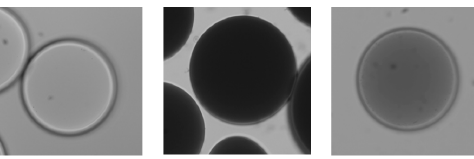
Figure 4. Toluidine blue (TBO) stained PEG SCPs before functionalization with crotonic acid (CA) ( left ). After CA functionalization PEG-CA SCPs bind TBO and acquire a dark color ( middle ). Reduced take-up of TBO after functionalization of CA groups with cellobiose ( right ).